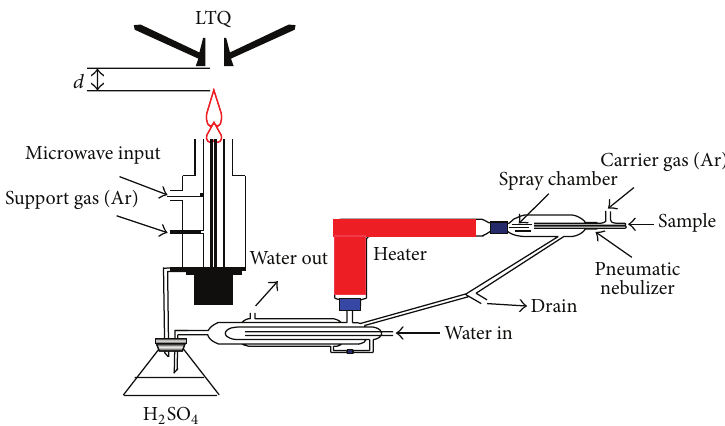
Figure 1: The schematic illustration of the experimental setup including the drying system and MPT.